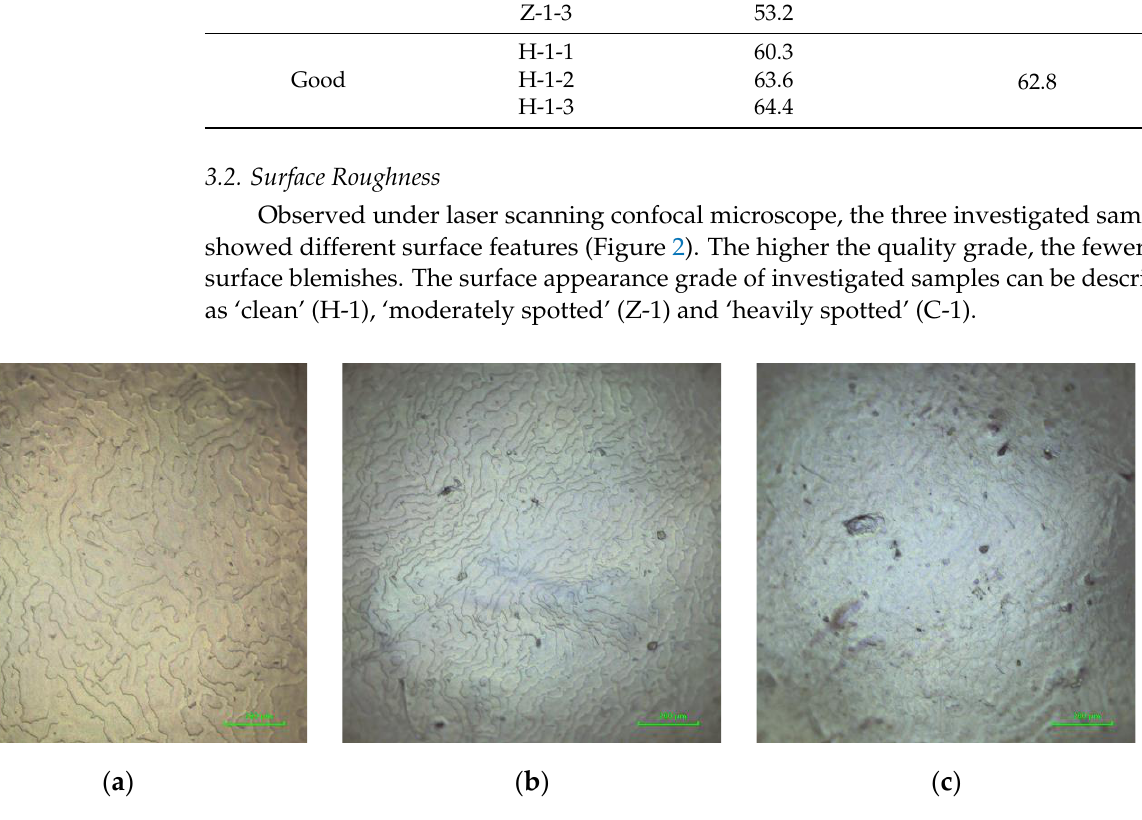
Figure 2. Surface morphology images of pearl samples with different quality grades under laser scanning confocal microscope, ( a ) sample H-1; ( b ) sample Z-1; ( c ) sample C-1 Table 2. Surface unevenness parameters of pearl samples with different quality.